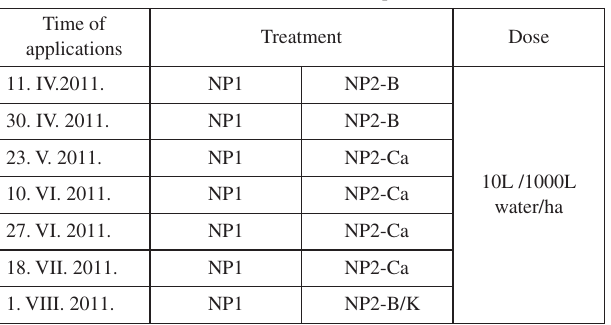
Table 2: Treatments of the experiment Time of applications